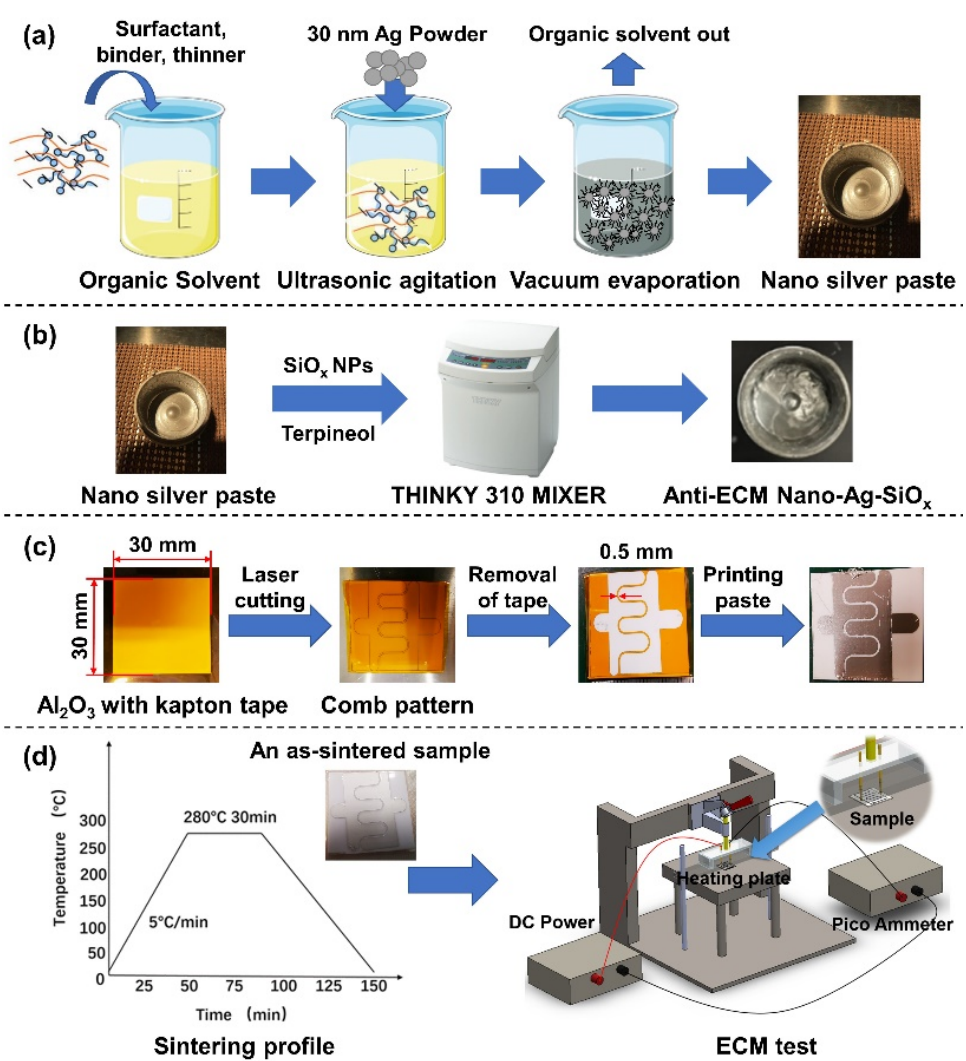
Figure 1. ( a ) Preparation process of nano silver paste; ( b ) preparation of proposed anti-ECM nano- Ag-SiO x composite paste; ( c ) preparation of ECM samples; ( d ) schematic of the sintering process and ECM test.